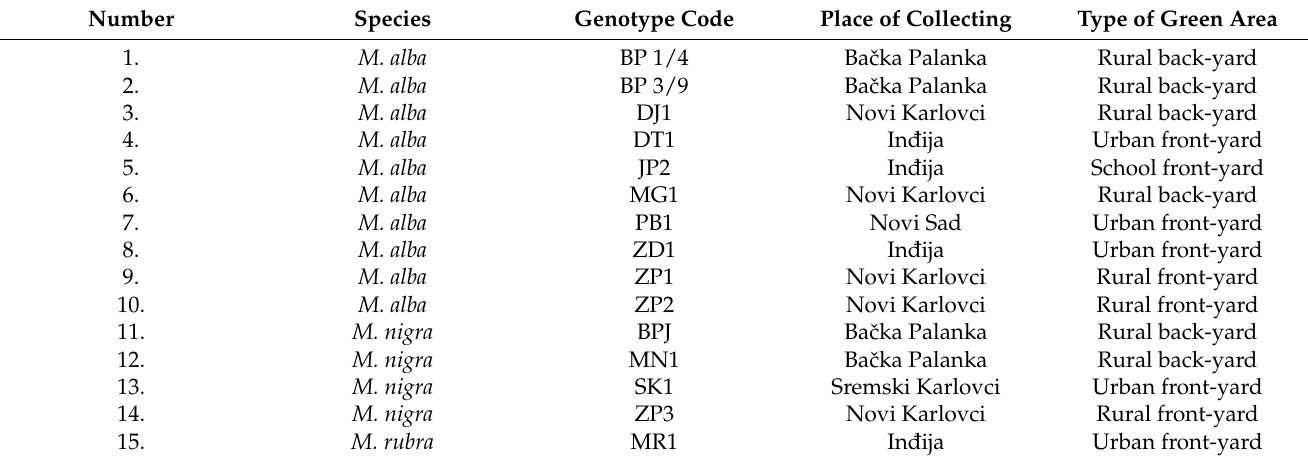
Table 1. Sampling locations in Northern Serbia and list of Morus species